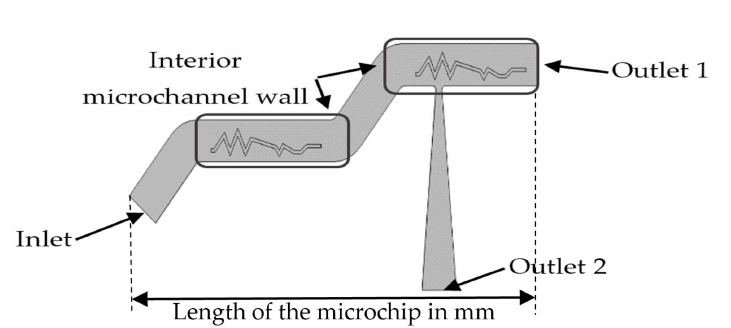
Figure 2. Microchip channel design with corrugated dragonfly wing patterns inside.